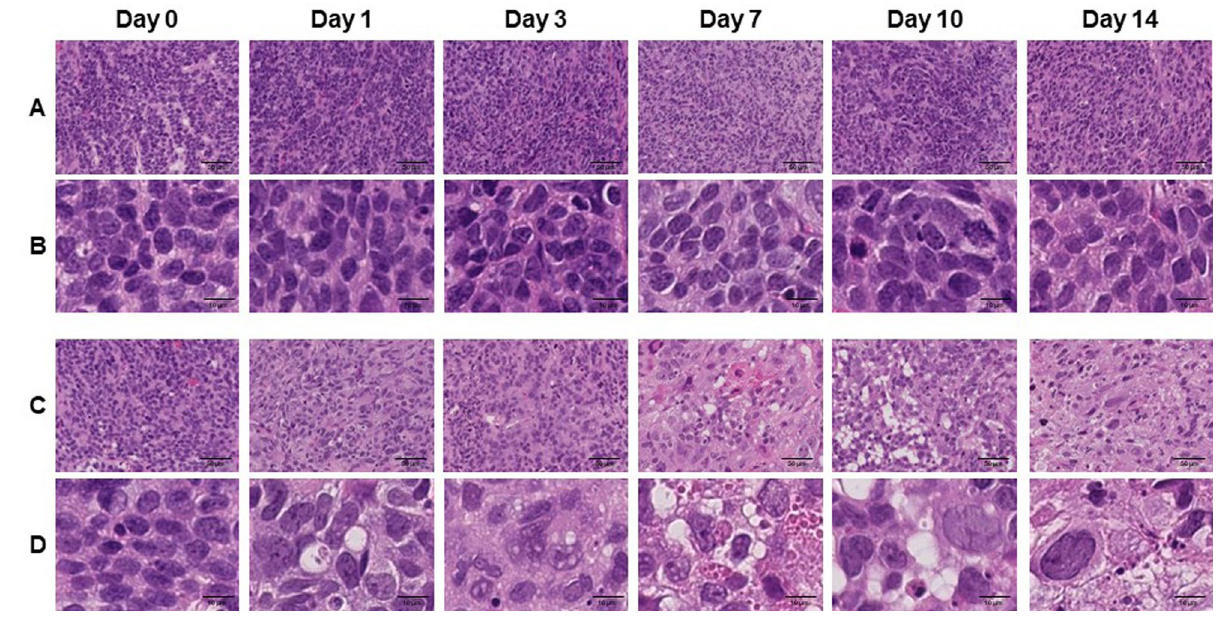
Figure 2. Hematoxylin and Eosin (HE) stained sections of LNZ308 tumors after irradiation. Tumors on right paws were irradiated on day 0 at the dose of 0 Gy ( A and B ) or 60 Gy ( C and D ). Photomicrographs of low ( A and C ) and high ( B and D ) magnification show HE stained tumor sections at days 0, 1, 3, 7, 10, and 14 after irradiation (N = 1 each treatment group).